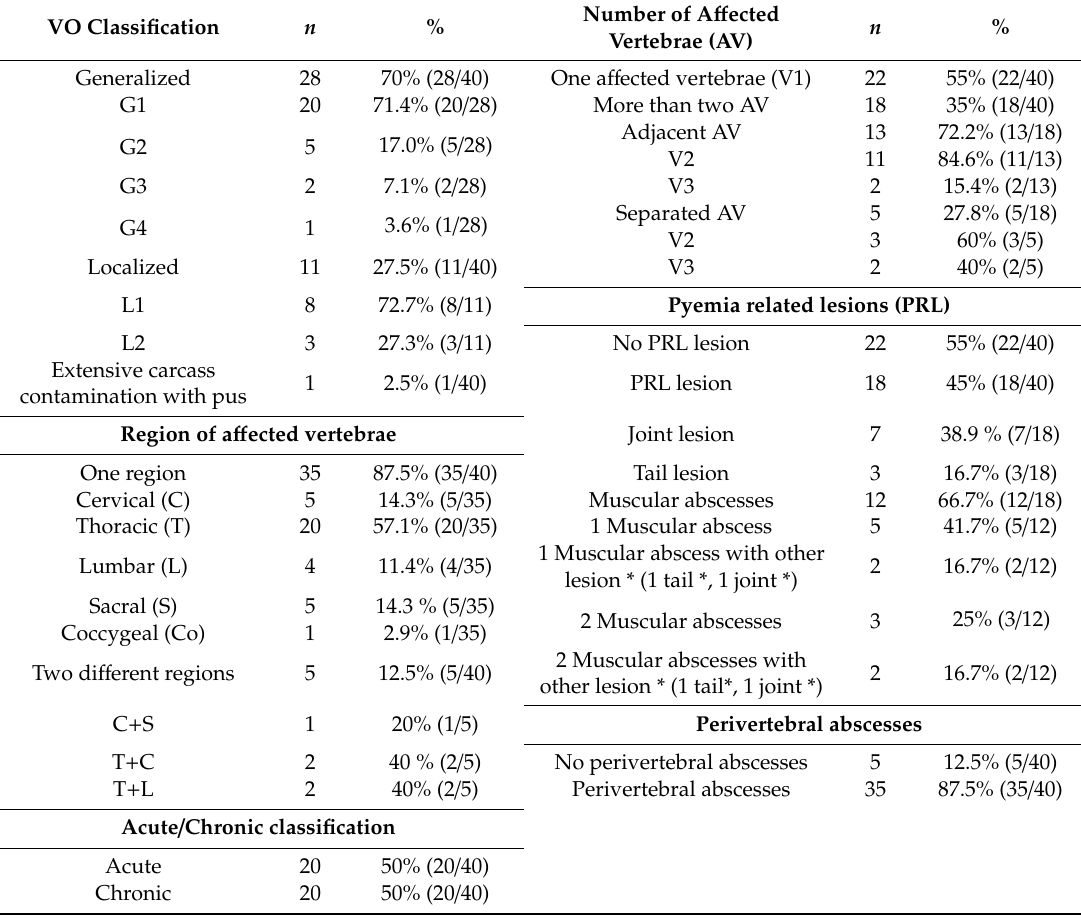
Table 2. Results of the classification scheme application to the 40 VO cases analyzed in the second stage of this study.